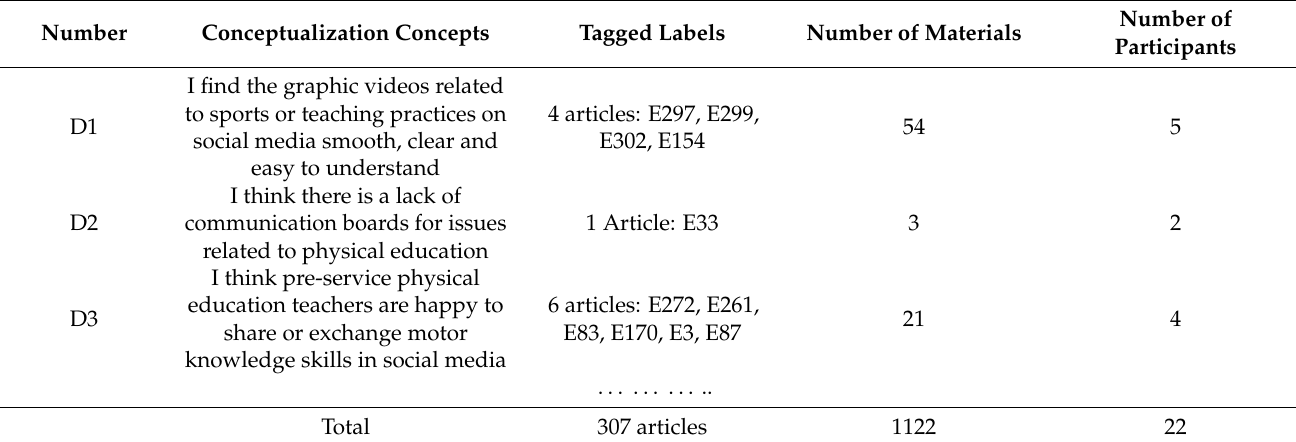
Table 4. Conceptualization results of 307 tagged